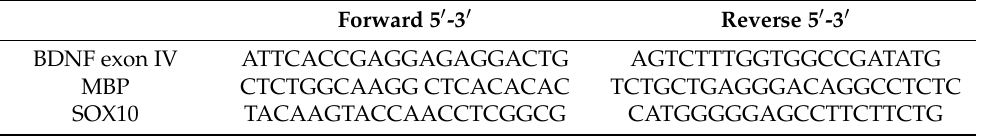
Table 3. Pirmer design for real-time